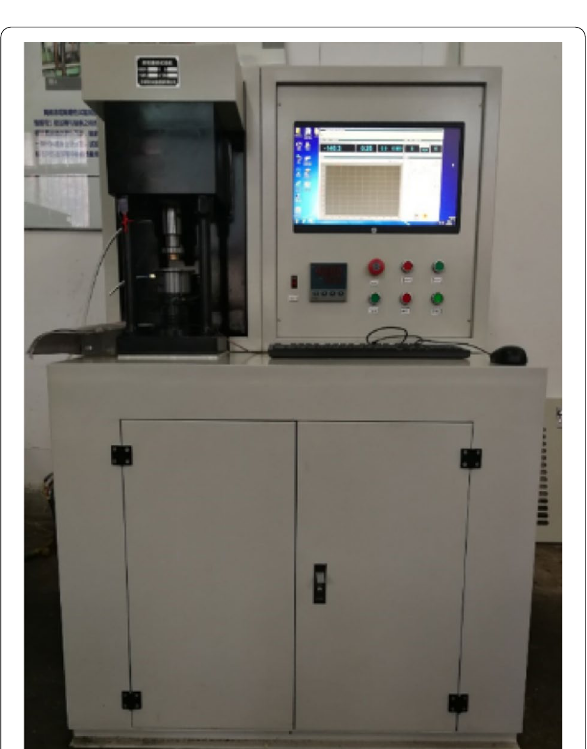
Figure 7 Photograph of the ring-on-disk